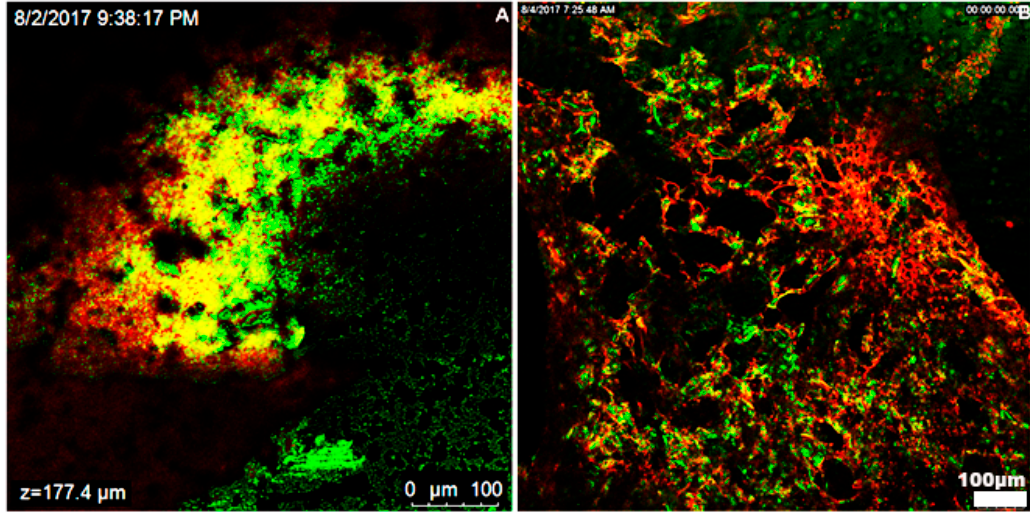
Figure 3. Confocal microscopical view of U. virens interaction with the host using WGA and PI fluorescent stains. ( A , B ), The chlamydospores are green to black, and plant cells appear red, while fungal hyphae and their secretions are yellow; bar; ( A , B ) = 100 μ m. Note: z is the thickness of the sample.